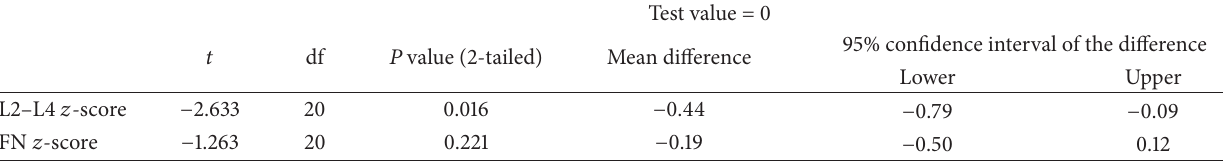
Table 3: 𝑡 -test of whether 𝑧 -scores for bone mineral density significantly differ from 0.